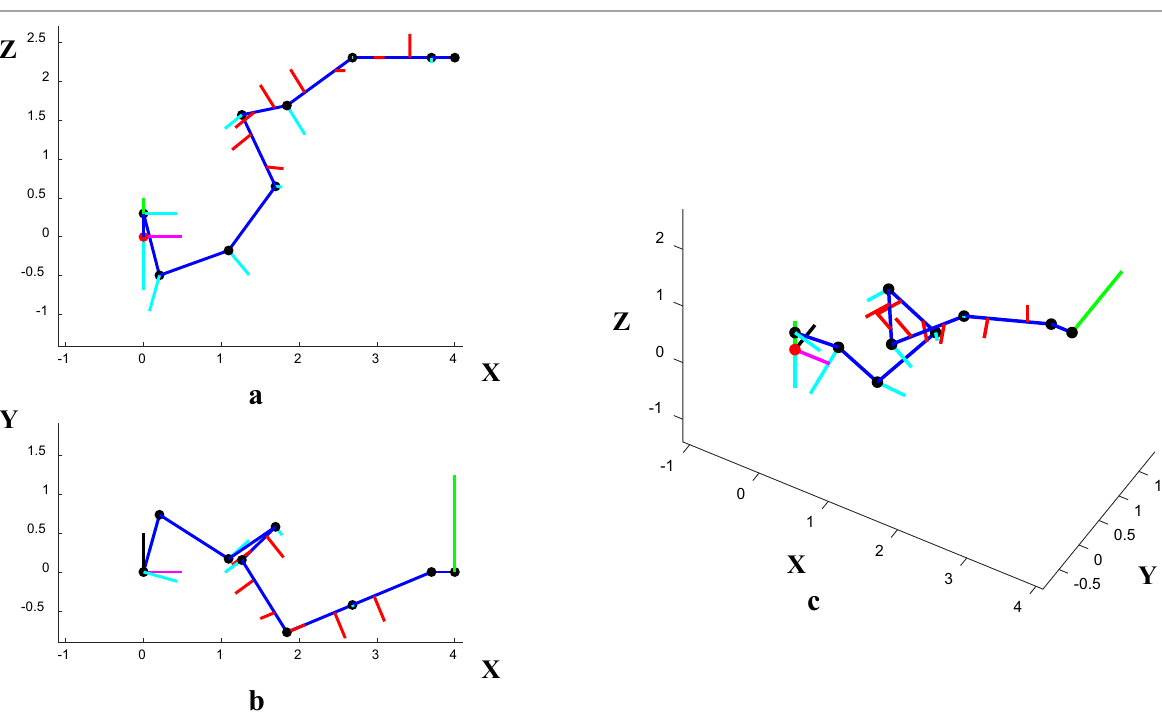
Fig. 11 The simulation arm and flying watch thrusts under the second level watch-actuator cooperation when the external reaction force on the end effector is [0,125,0] N (reduction rate 31.7%). a Front view. b Top view. c 3-D =